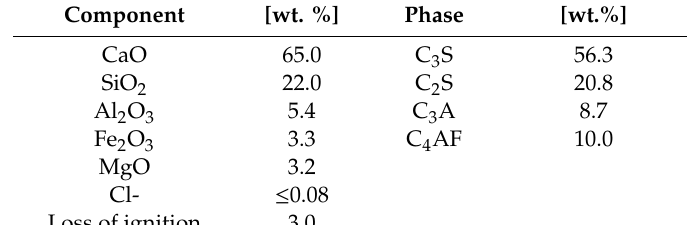
Table 1. Chemical and phase composition of Portland cement CEM I 52.5R.